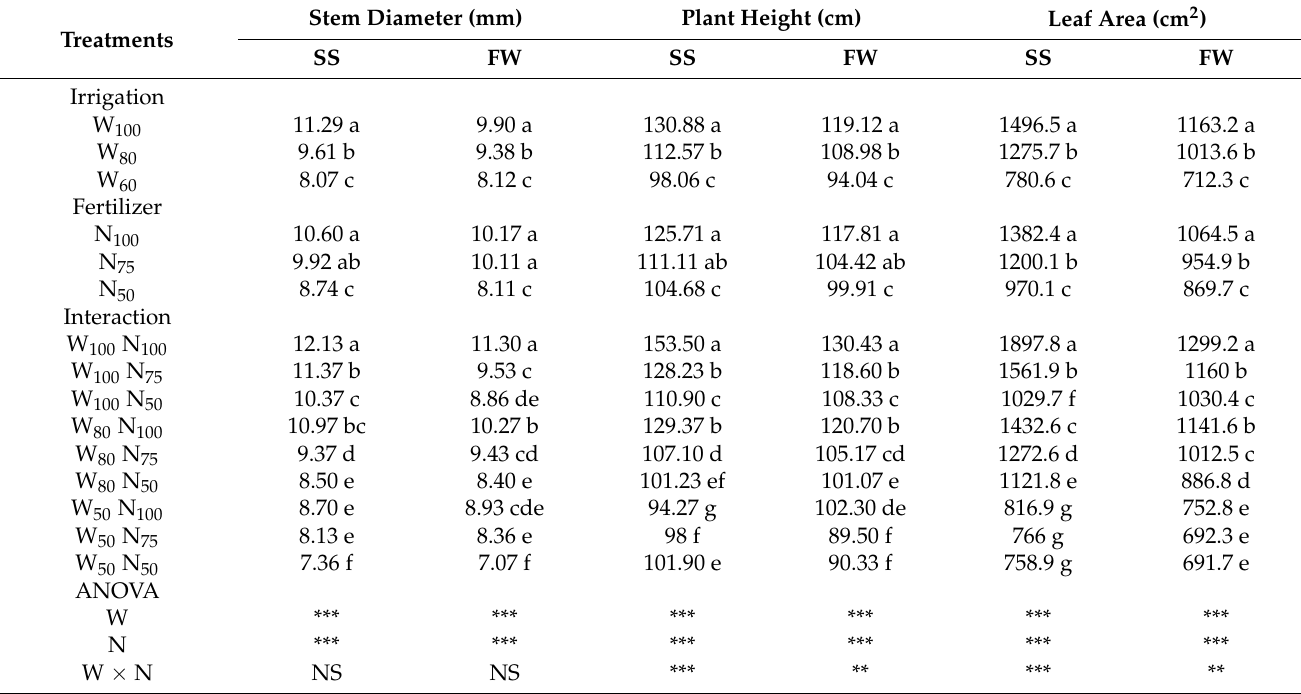
Table 2. Effect of water (W) and N on stem diameter, plant height, and leaf area during spring–summer (SS) and fall–winter (FW)